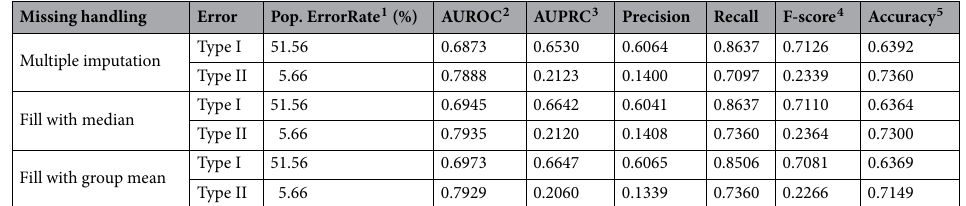
Table 4. Performance metrics for Type I/II errors using cutoff 0.33, with ARC removed. 1 Pop. ErrorRate is the true observed APACHE error rate in the entire population. 2 AUROC is the area Under the receiver operating characteristic curve. 3 AUPRC is the area Under the precision–recall curve. 4 F-score = 2 × Precision × Recall Precision + Recall . 5 Accuracy = negative.